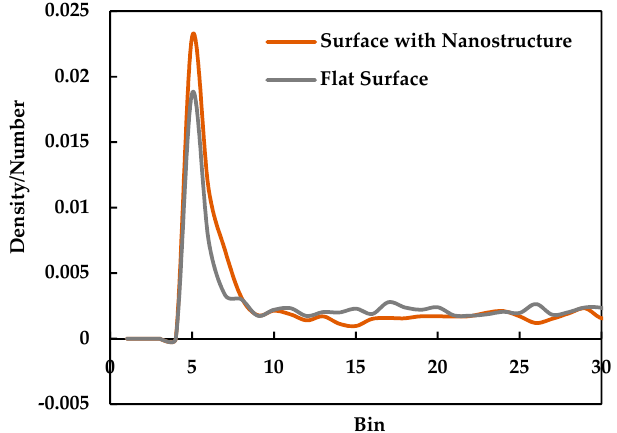
Figure 12. Comparison of density profile of argon at 4 ns for nano-structured surface with smooth surface.